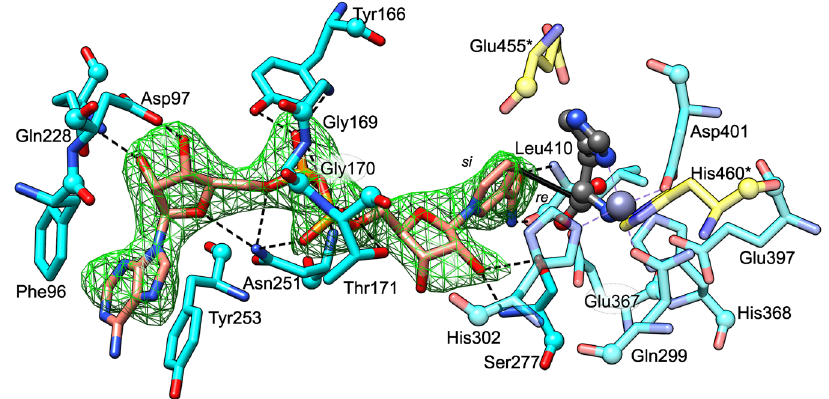
Figure 6. NAD + binding by Mt HDH. NAD + (salmon) is contoured with the F o − F c omit map (green mesh) at 4 σ level. The product, His (gray C atoms, ball-and-stick), mimics the position of HOL. Hydrogen bonds between the protein and NAD + atoms are shown as dashed black lines, whereas the solid black line represents the path of hydride transfer. Residues from domain II are semitransparent, whereas those from domain IV * are yellow. Italicised re and si indicate the two prochiral faces of the C4 atom of